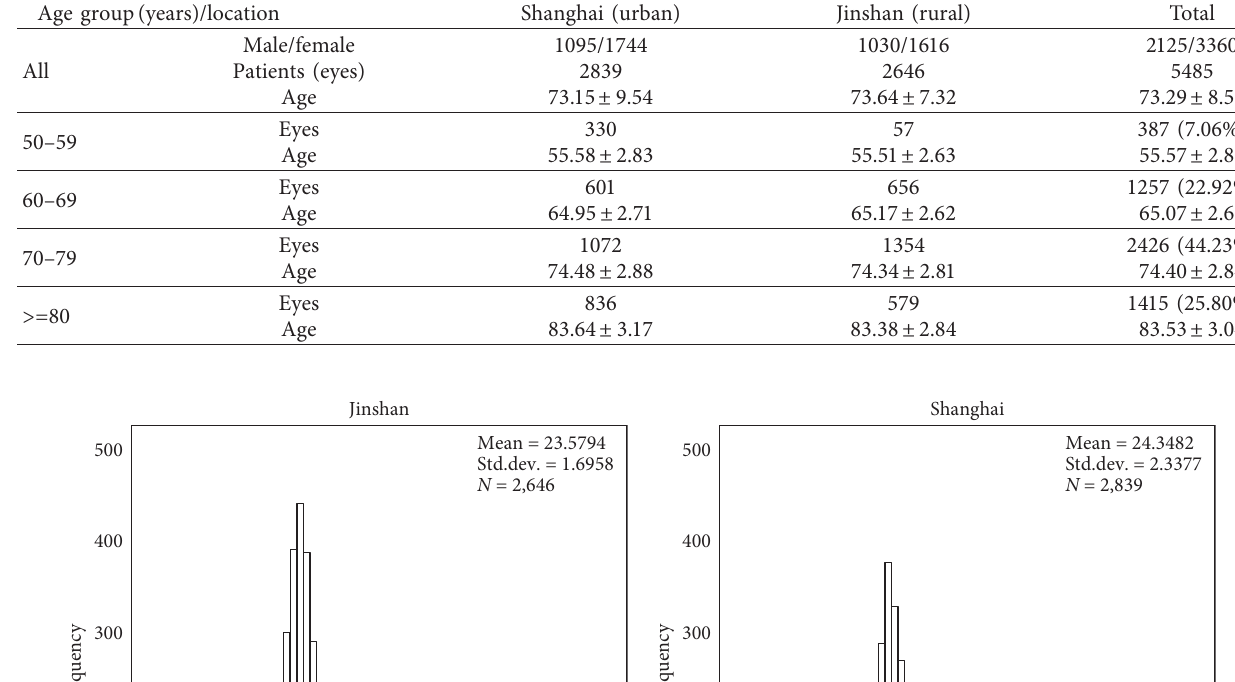
Table 1: Demographic features of the present study population.